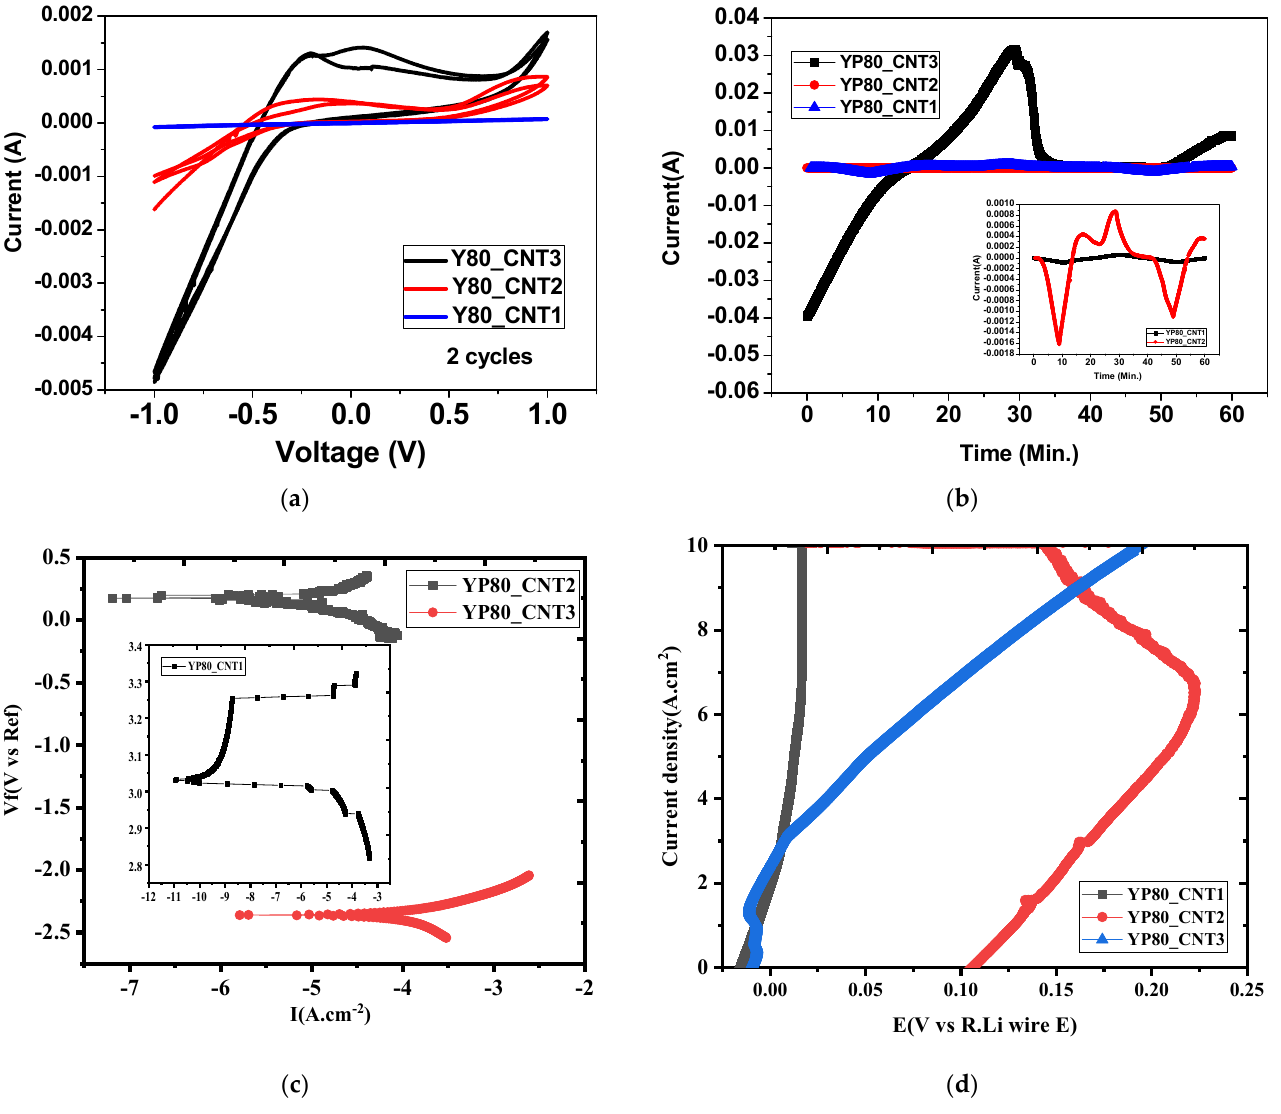
Figure 5. The electrochemical characteristic evaluation results; ( a ) cyclic voltammogram, ( b ) t-I plot, ( c ) Tafel plot, and ( d ) LSV plot.